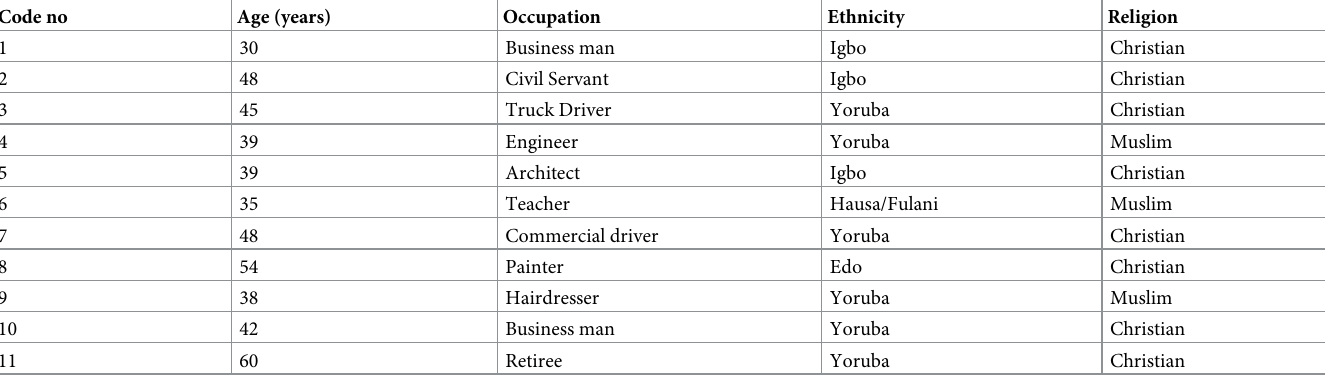
Table 11. Socio demographic characteristics of